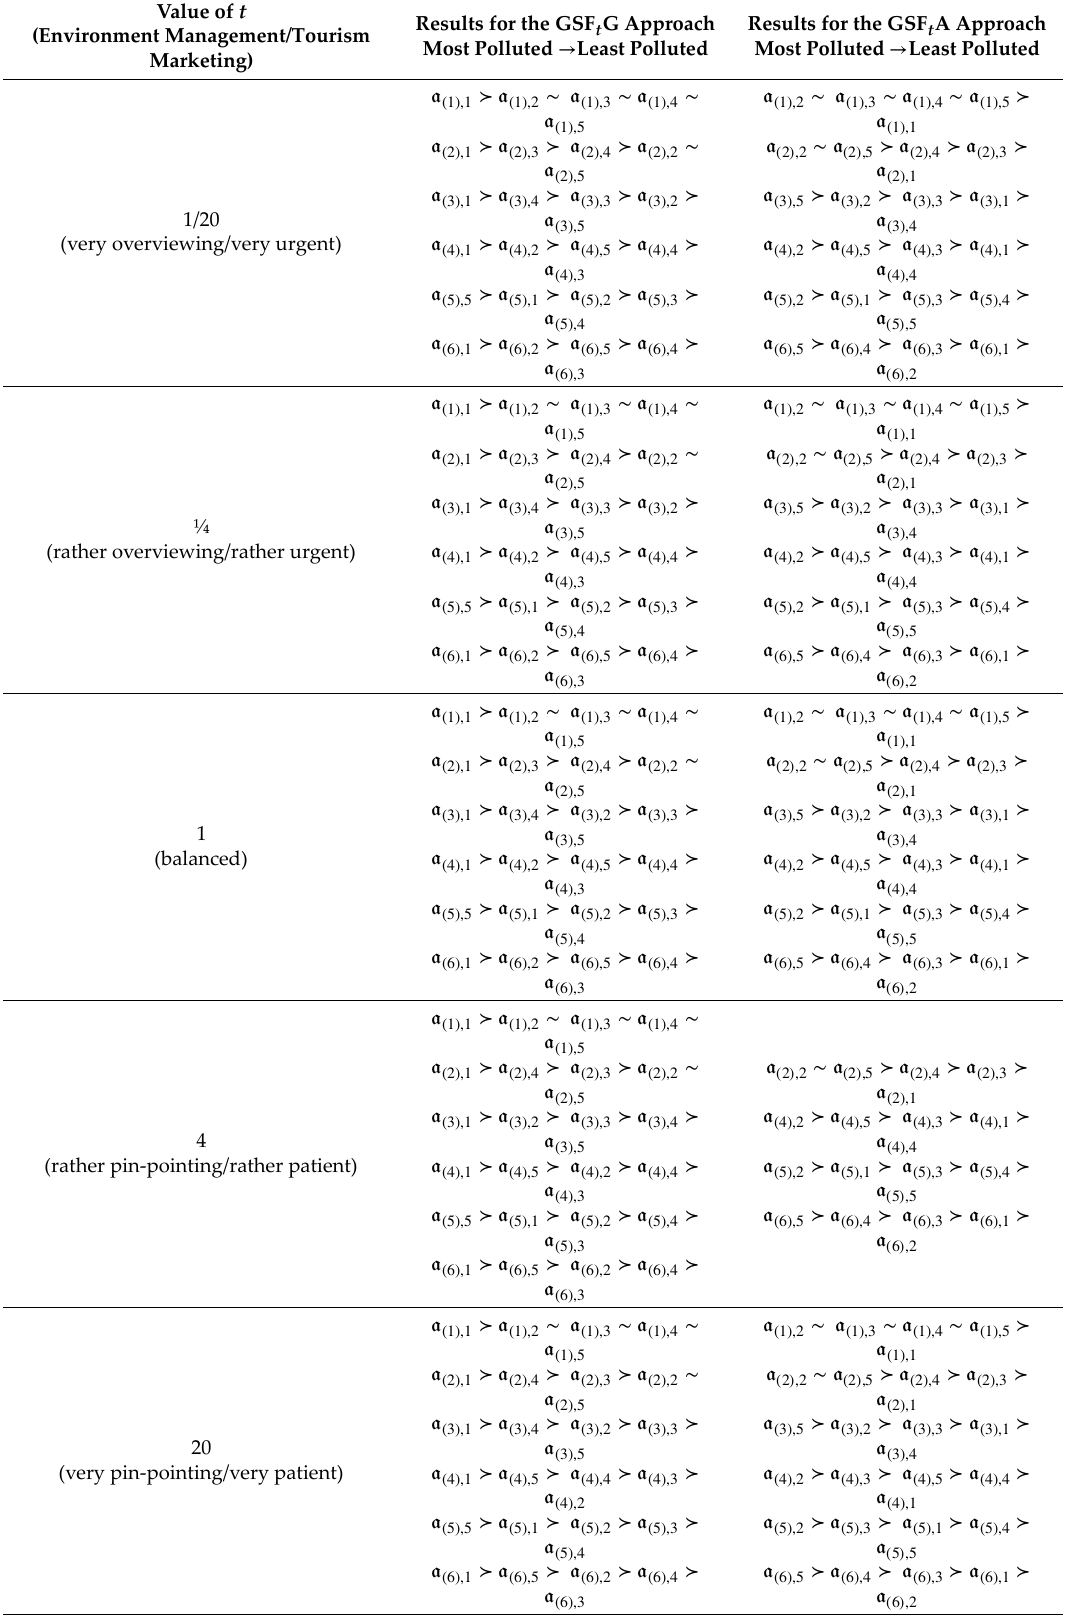
Table 2. Results for the GSF 𝑡 G and GSF 𝑡 A approaches for the chosen